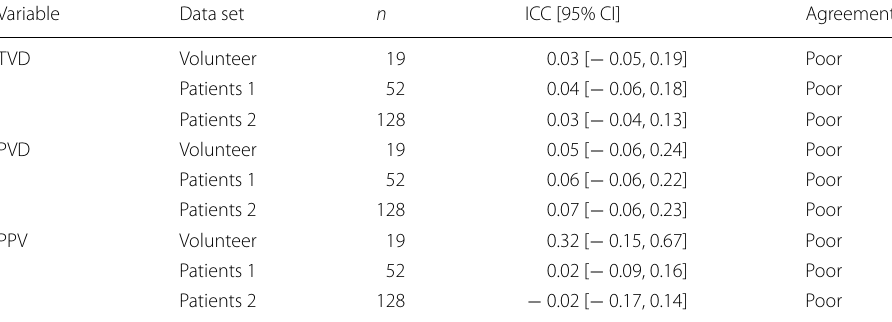
Table 1 Intraclass correlation coefficient between AVA 3.2 and AVA 4.1